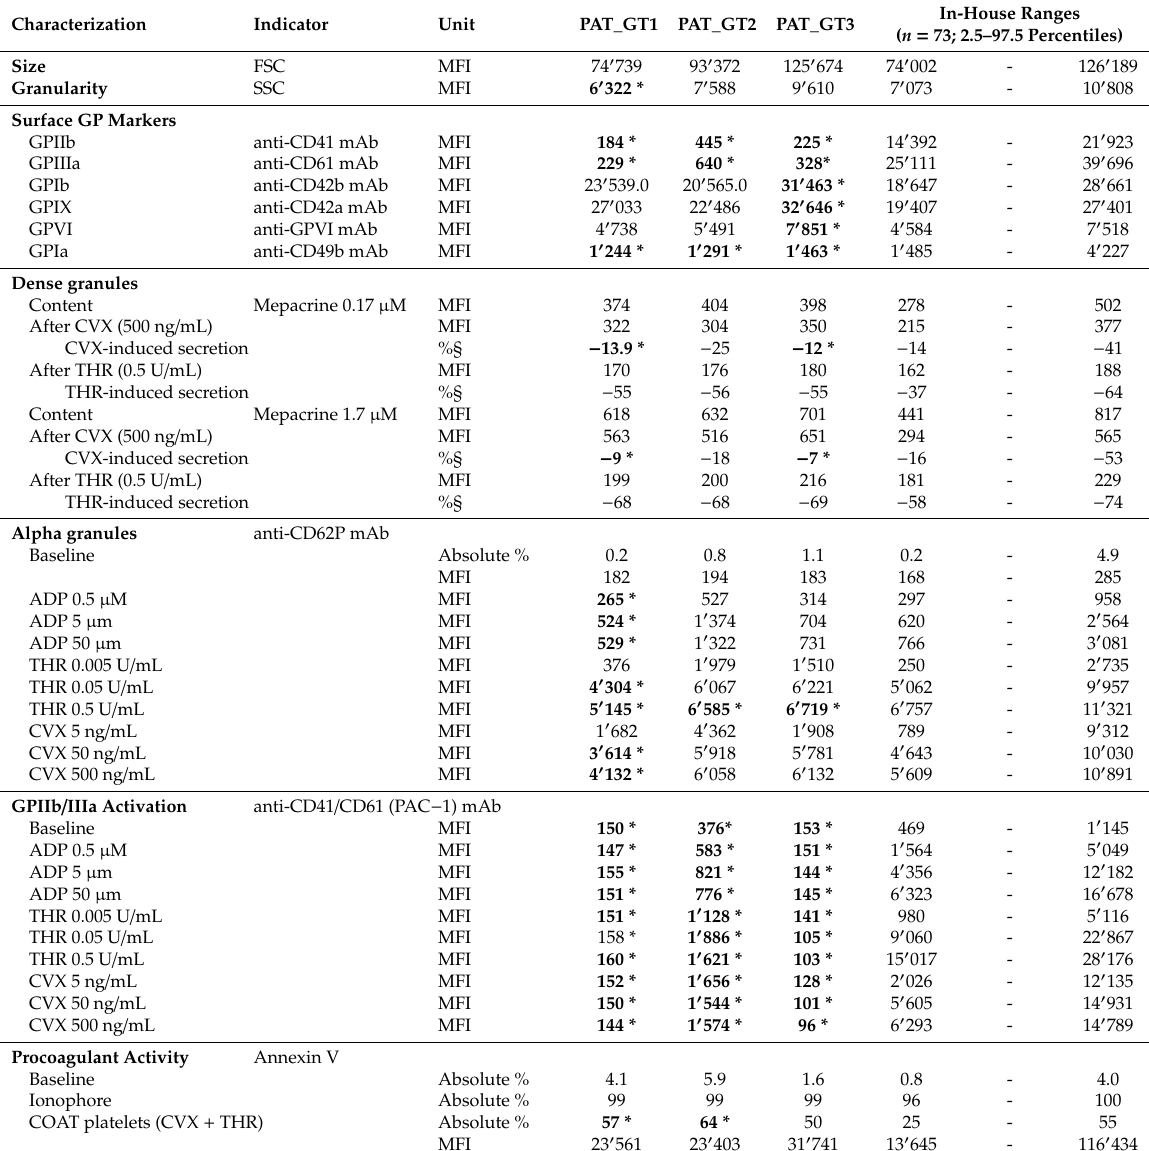
Table 1. Patient Characteristics Revealed by Flow Cytometric Analysis and In-House Reference